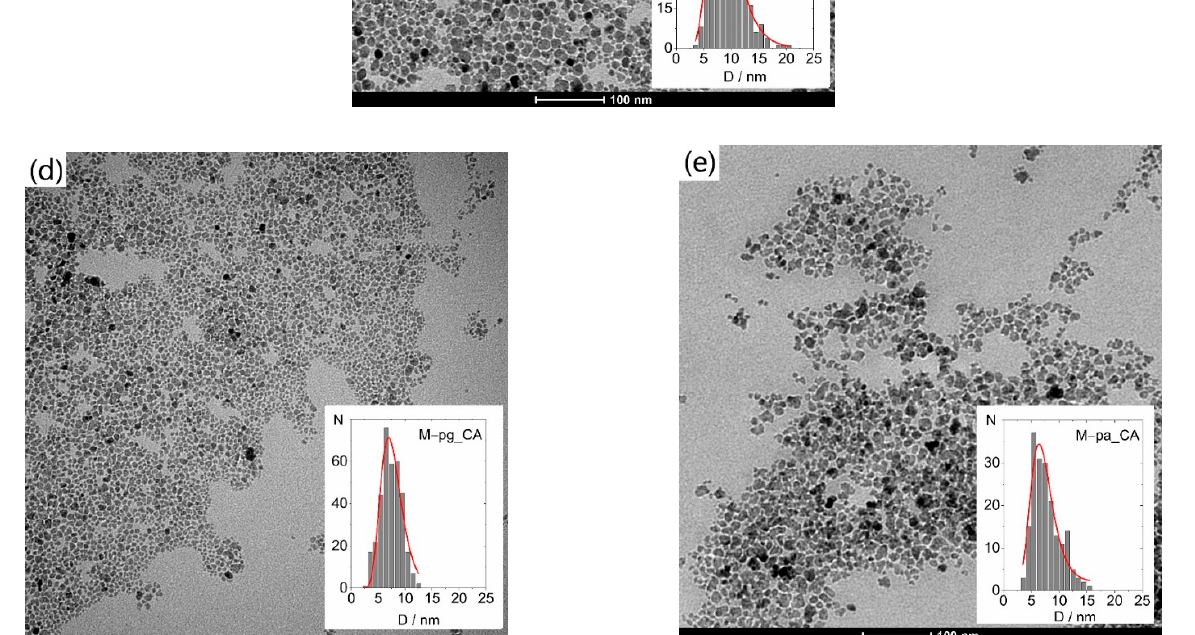
Figure 9. Typical TEM images of the grid-dried citric acid-based ferrofluids with the corresponding size distributions for coated NPs in samples ( a ) M–g_CA, ( b ) M–p_CA, ( c ) M–a_CA, ( d ) M–pg_CA and ( e ) M p a_CA.